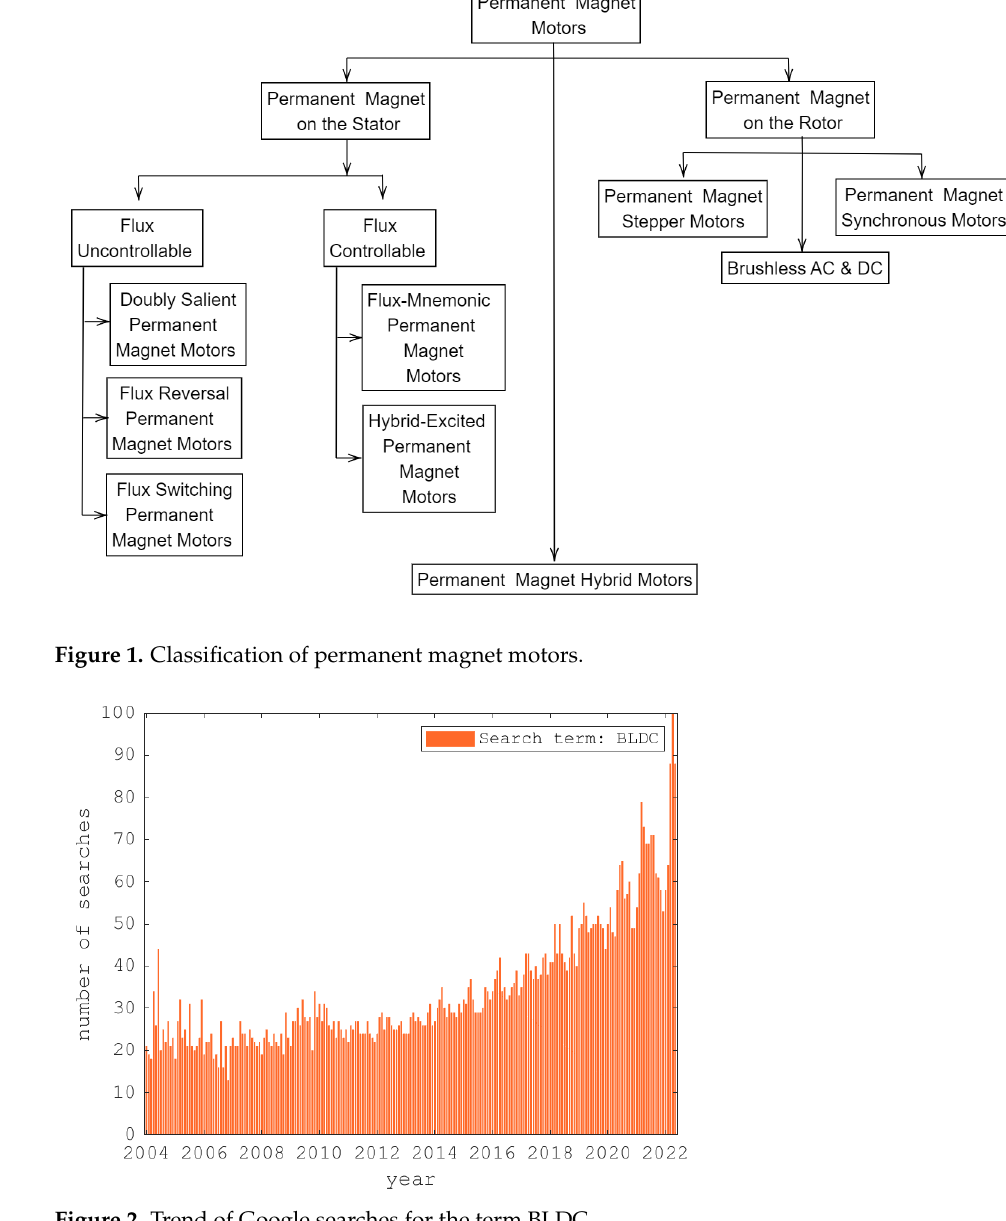
Figure 2. Trend of Google searches for the term